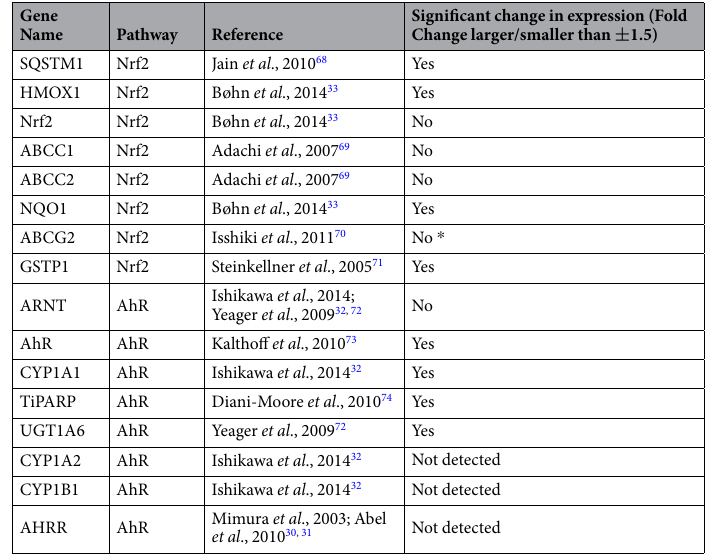
Table 1. Expression changes upon coffee/xenobiotics exposure of initial set of genes selected based on existing literature. ‘ * ’Indicates genes found to be significantly differentially expressed (Fold change >± 1.5) in Turkish Coffee only. Genes were considered to be responsive if they were expressed in at least two coffee samples.